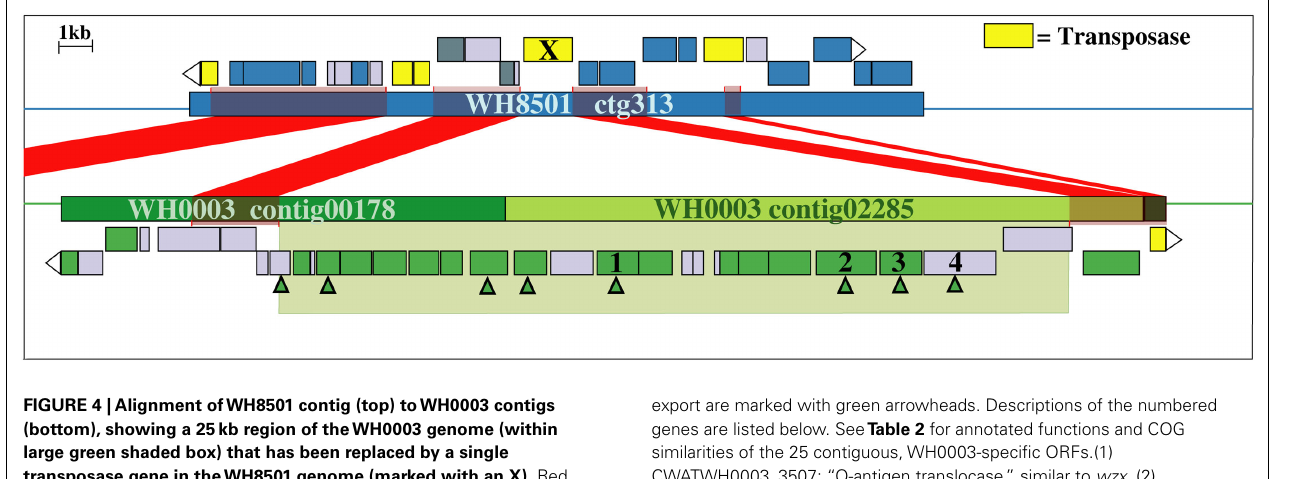
FIGURE 4 |Alignment ofWH8501 contig (top) toWH0003 contigs (bottom), showing a 25kb region of theWH0003 genome (within large green shaded box) that has been replaced by a single transposase gene in theWH8501 genome (marked with an X). Red connecting bars and shading indicate regions of sequence homology. Hypothetical genes are in light gray, transposase genes are yellow and ORFs with other annotated functions are in blue (WH8501) or green (WH0003). ORFs with functions related to polysaccharide synthesis or